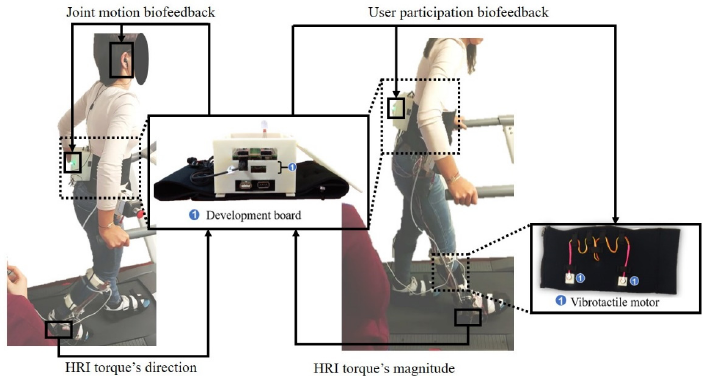
Figure 3. Pictures of participant 1 and technical person during joint motion and user participation biofeedback training with indication of the used cue (visual and auditory or vibrotactile) and its meaning (HRI torque’s direction or magnitude).